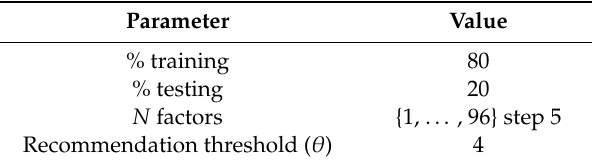
Table 2. Cross-validation